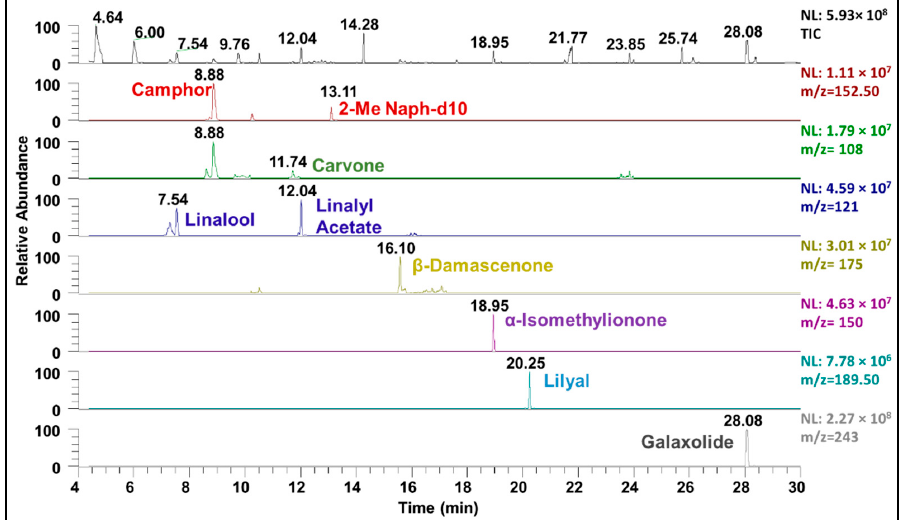
Figure 2. SIM-B chromatogram of the sample collected in the house.